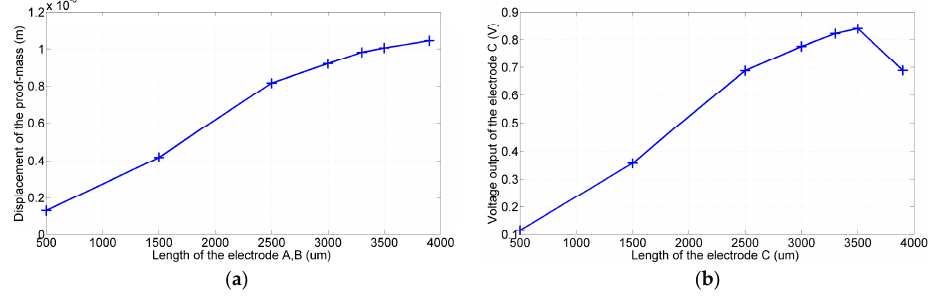
Figure 4. Simulation results: ( a ) Displacement of the proof mass increased with the lengths of the drive electrode pair ( A , B ). ( b ) Under the same actuation conditions, voltage output of electrode C varied with its length. The optimal length was 3500 μ m.